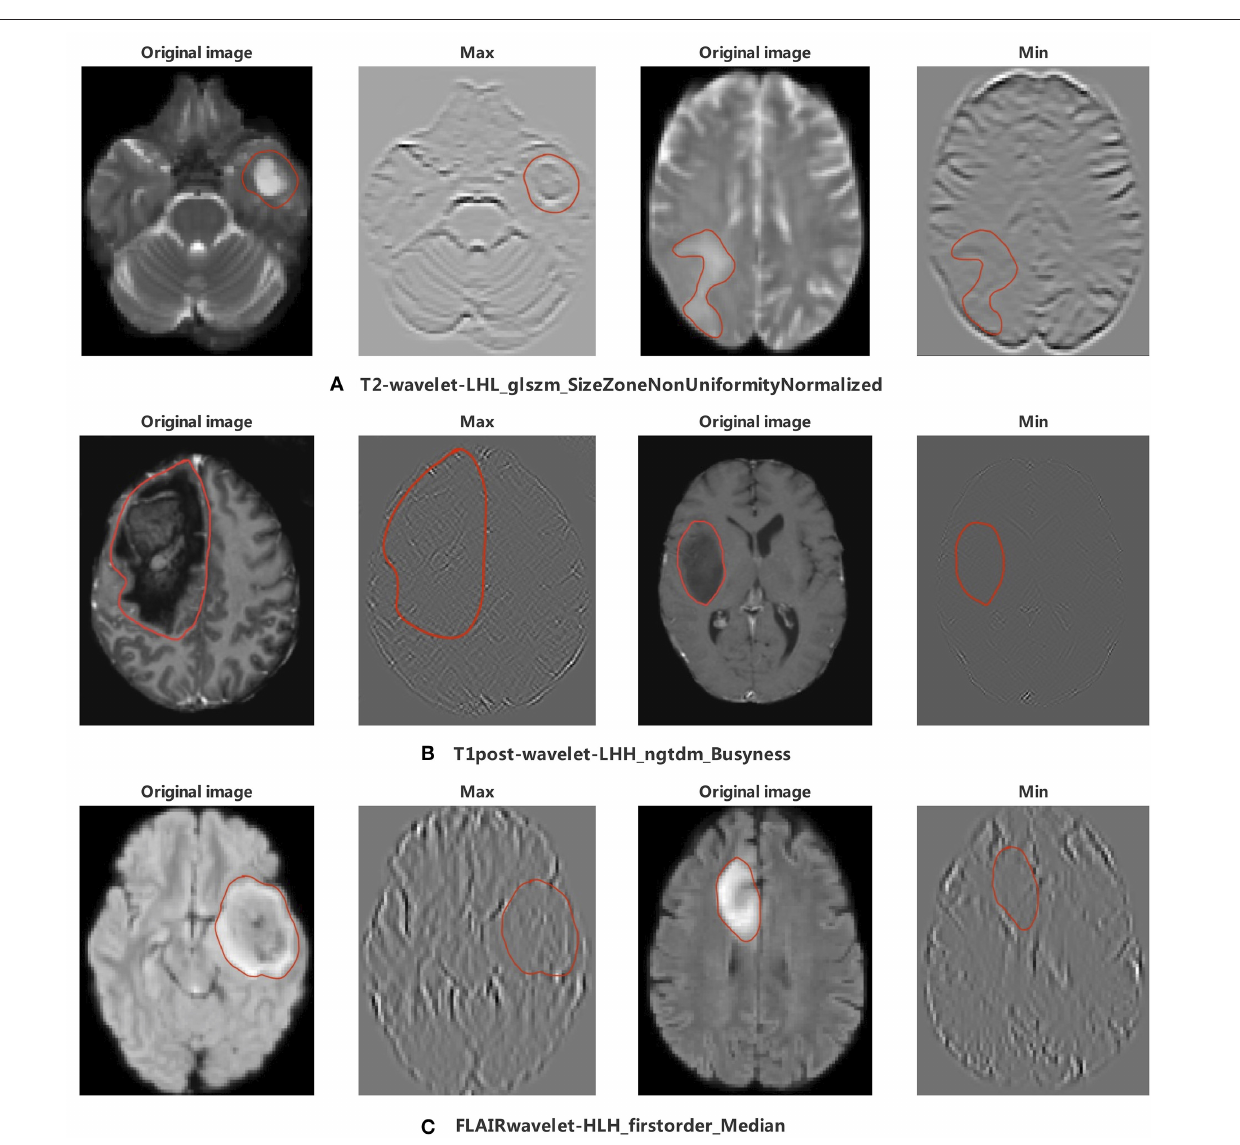
FIGURE 8 | The appearance of the MR image corresponding to the top 3 radiomic features in glioma. The region encircled in red represents the lesion boundary. (A) Images corresponding to the maximum and minimum of T2-wavelet-LHL_glszm_SizeZoneNonUniformityNormalized. (B) First column images are the Wavelet images corresponding to the maximum and minimum value of T1post-wavelet_LHH_ngtdm_Busyness, second column images are original images of wavelet images. (C) Images corresponding to the maximum and minimum value of FLAIR-wavelet-HLH_firstorder_Median.